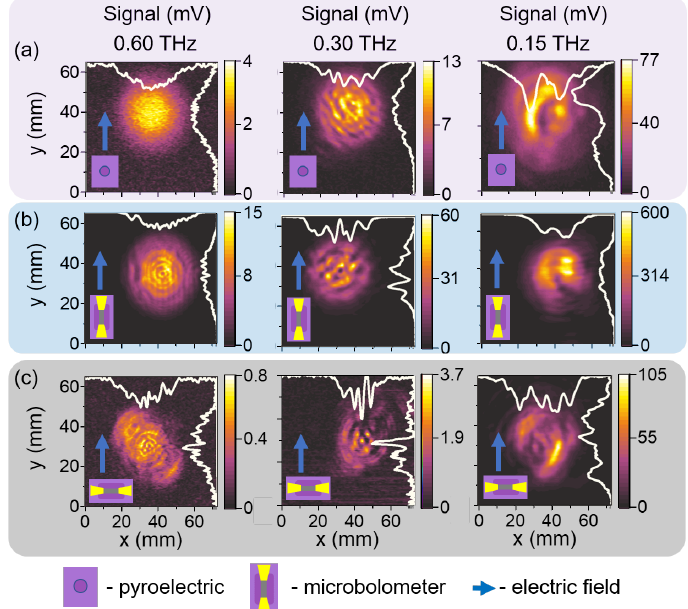
Figure 3. Scheme of polarisation orientation and THz beam profiles obtained using electronic multiplier chain source operating in a continuous wave (CW) mode at different frequencies: 0.6 THz, 0.3 THz and 0.15 THz. Reference measurements using pyroelectric detector ( a ); results using microbolometer when the dipole antenna is in parallel to the electric field of the incident light ( b ); results using microbolometer when the dipole antenna is perpendicular to the electric field of the incident light ( c ). White lines indicate intensity cross sections along the relevant